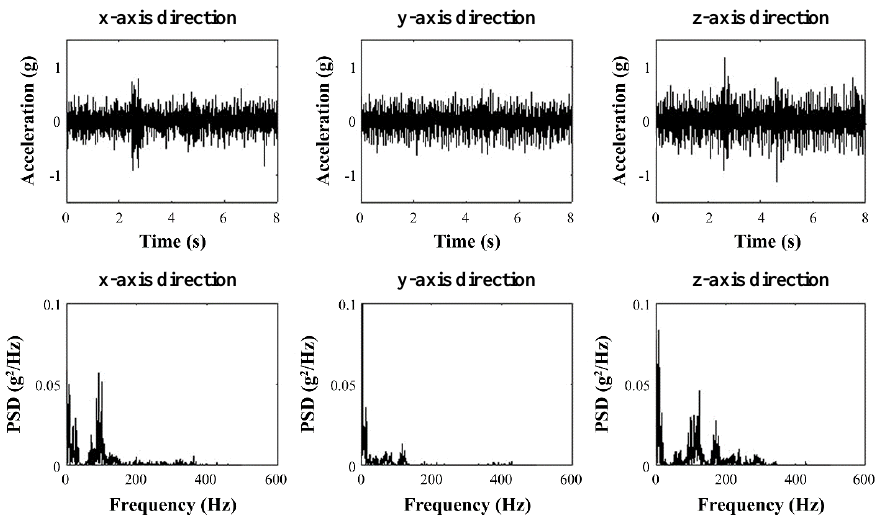
Figure 2. Driving vibration in a time domain and power spectral density of driving vibration.